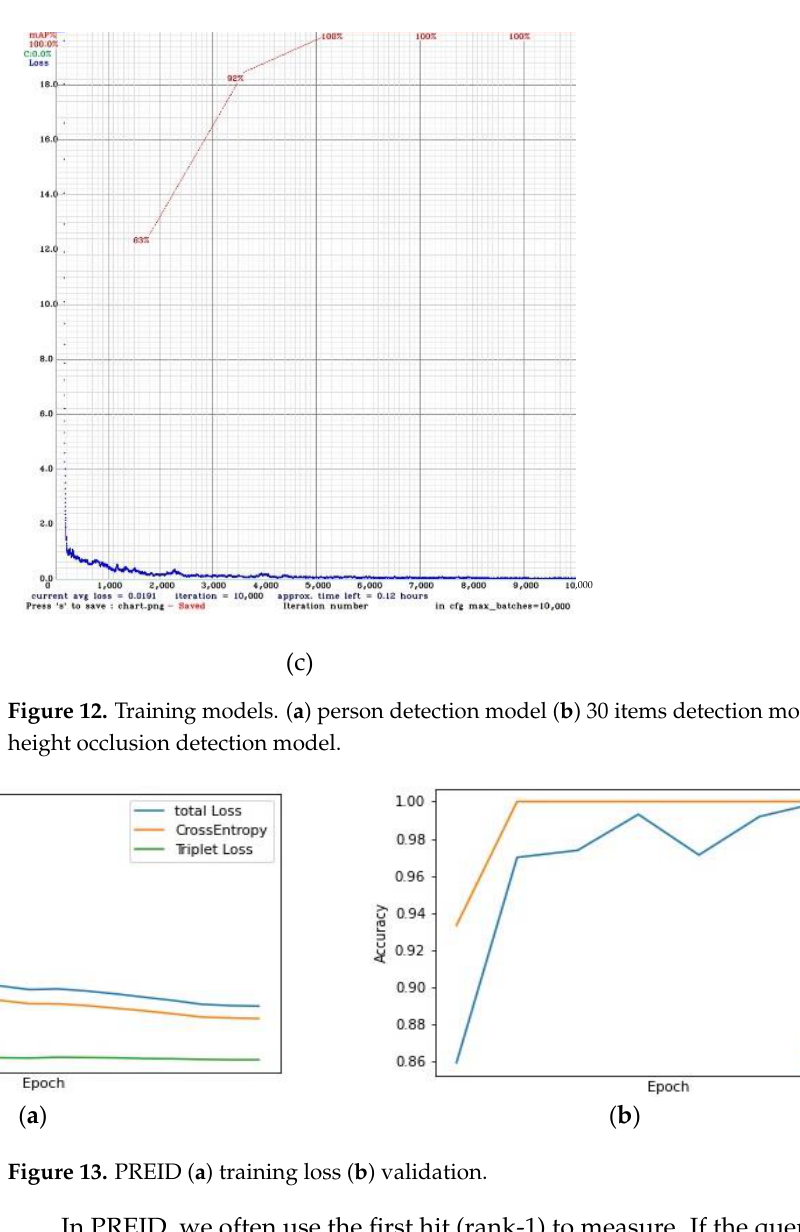
Figure 12. Training models. ( a ) person detection model ( b ) 30 items detection model ( c ) stacking and height occlusion detection model. Table 3. The results of YOLO v4 model.